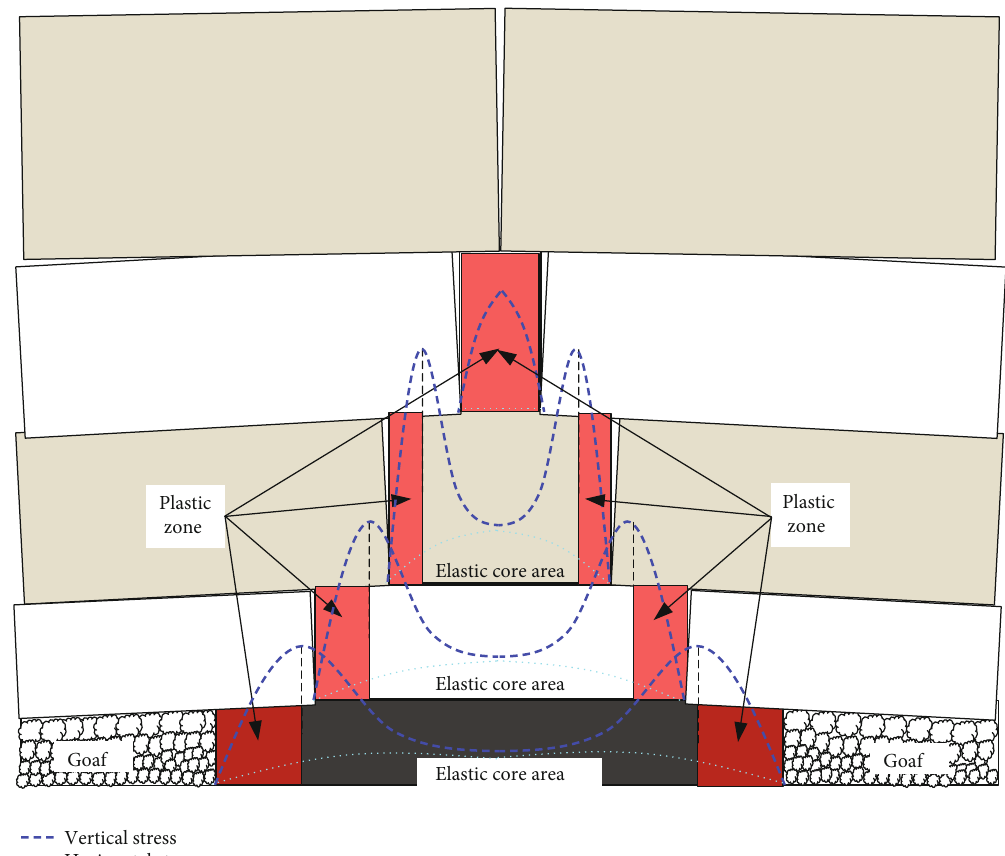
Figure 2: Vertical stress distribution of coal/rock pillar from No.